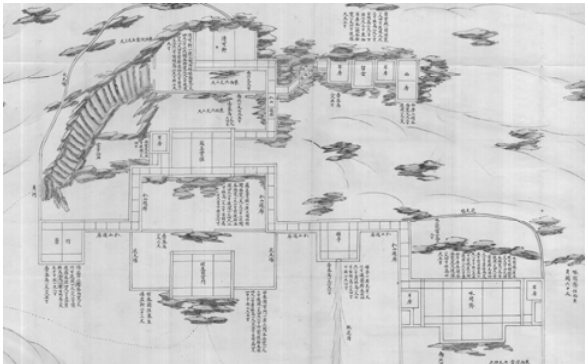
Fig. 6. A survey drawing of Da xilou 大戏楼 [The Opera Tower], 1950s (From: Tsinghua University, The Summer Palace , China Architecture & Building Press ，